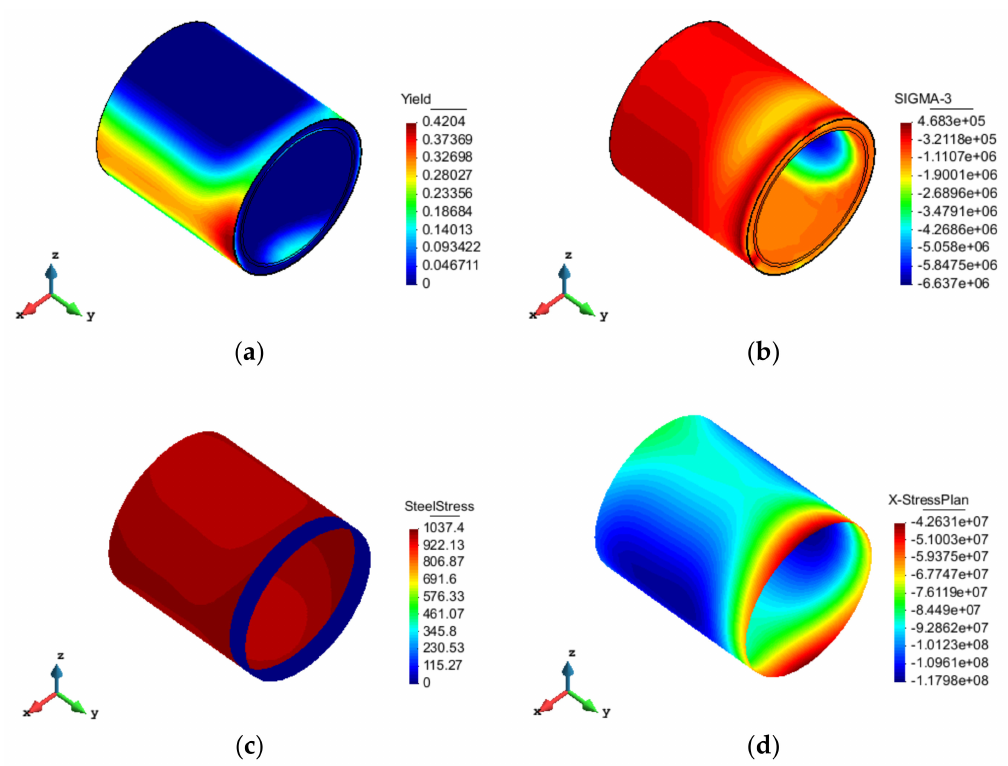
Figure 15. Nephogram of case 7: ( a ) damage, ( b ) 3rd principal stress, ( c ) wire stress, ( d ) cylinder stress. 5.2.3. Case 8: 10% Breakage Ratio and Breaking at Random Location The obtained nephogram is shown in Figure 16.